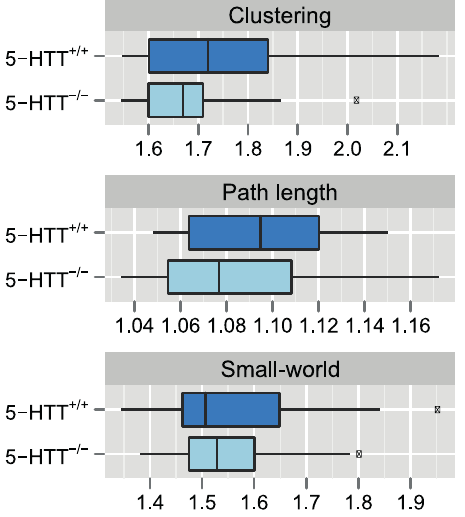
Figure 7. Network parameters from seed-based graph analysis of DTI tractography data. Structural brain networks were construct- ed from DTI-based fiber tracts among 23 bilaterally positioned cortical and subcortical gray matter ROIs. The edges between the regions were weighted by the mean fractional anisotropy along the tracts. The boxplots display three global network parameters that capture key properties of the networks: the clustering coefficient (i.e., average of local clustering coefficients), the characteristic path length (i.e., average of shortest path lengths), and the small-worldness (i.e., ratio of normalized clustering coefficient and normalized characteristic path length).